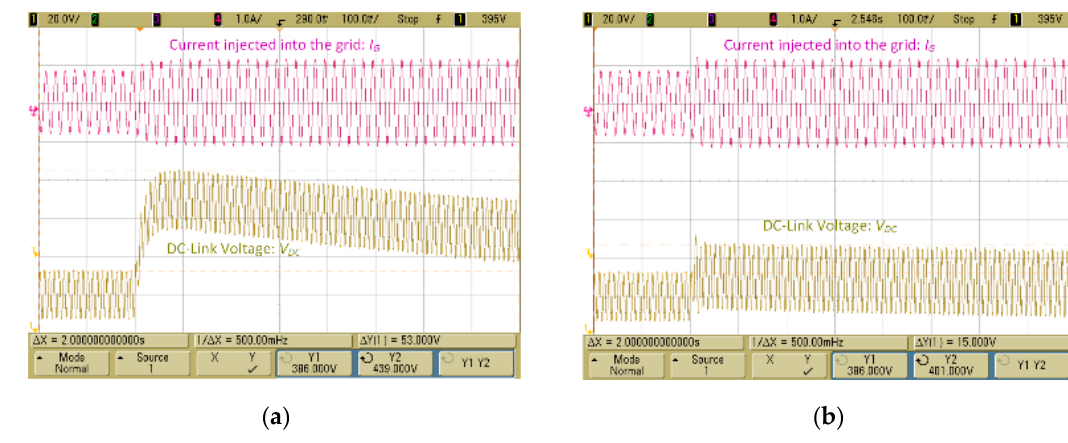
Figure 12. Power step from 150 W to 200 W. C DC : 50 µF. ( a ): Fc TVDC : 10 Hz. ( b ): Fc TVDC : 45 Hz.